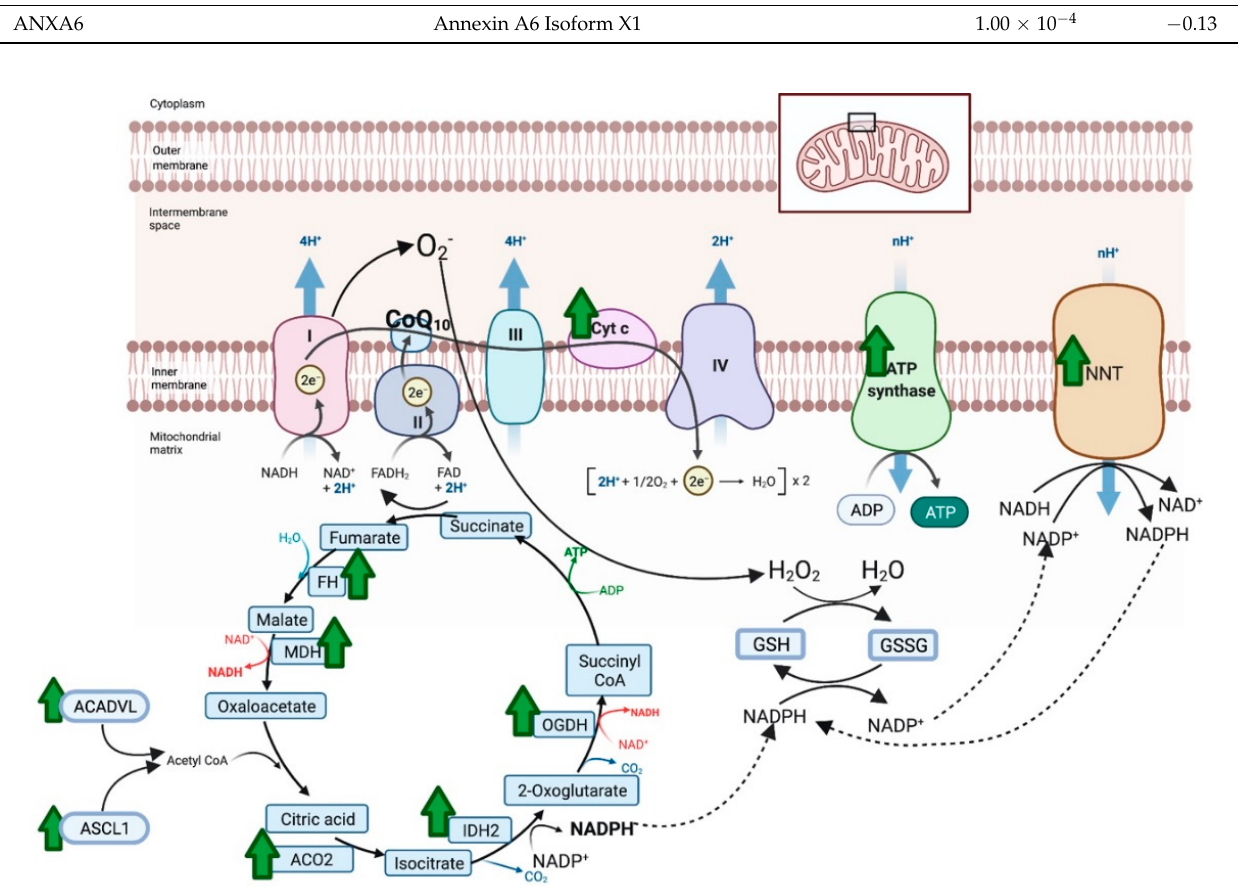
Figure 5. Proteins with significantly increased expression (green arrow) in the mitochondria of horses on NACQ compared to placebo. Horses with NACQ supplementation had upregulation of two cytochrome C subunits, one subunit of ATP synthase, reduced glutathione (GSH), oxidized glutathione (GSSG), NAD(P) transhydrogenase (NNT), fumarate hydratase (FH), malate dehydrogenase (MDH), 2-oxoglutarate dehydrogenase (OGDH), NADP-dependent isocitrate dehydrogenase (IDH2), aconitase (ACO2), Very Long-Chain Specific Acyl-CoA Dehydrogenase Mitochondrial (ACADVL), and Long-Chain-Fatty-Acid–CoA Ligase 1 Isoform X2 (ASCL1). Created with BioRender.com (accessed on 26 October